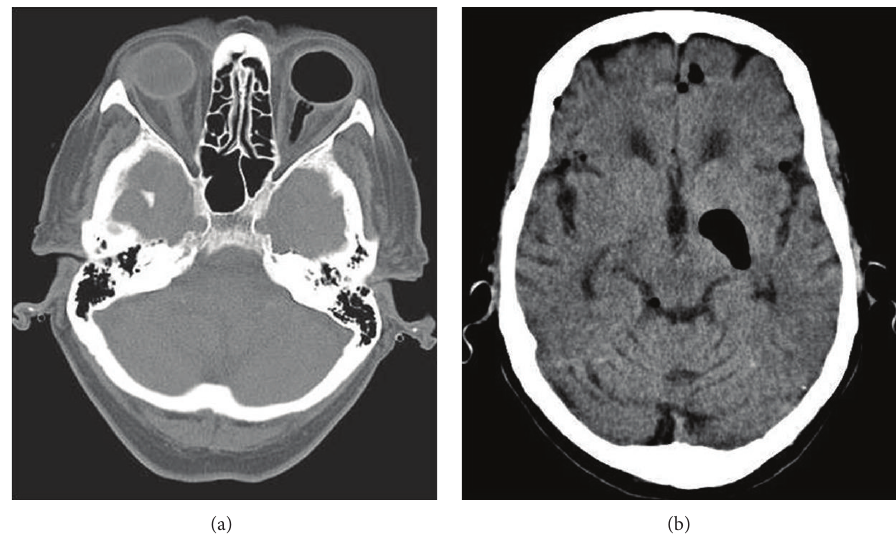
Figure 1: CT scan showing gas in the left eye and optic nerve (a) and intracranial air adjacent to the basal ganglia (b).